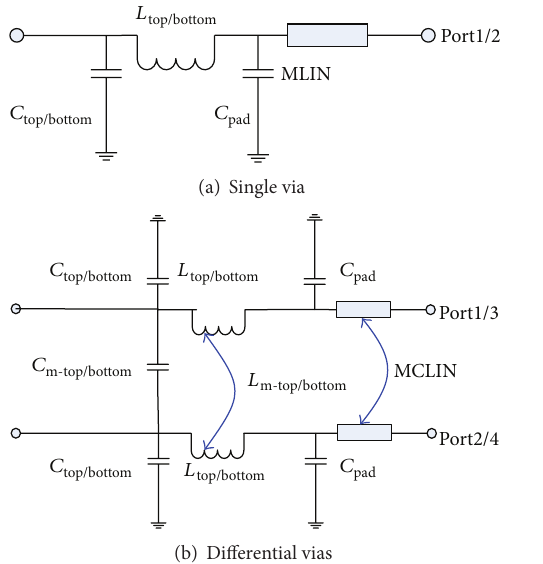
Figure 6: Equivalent circuit of top (bottom) layer microstrip to the upper (lower) part of the via vertical conversion